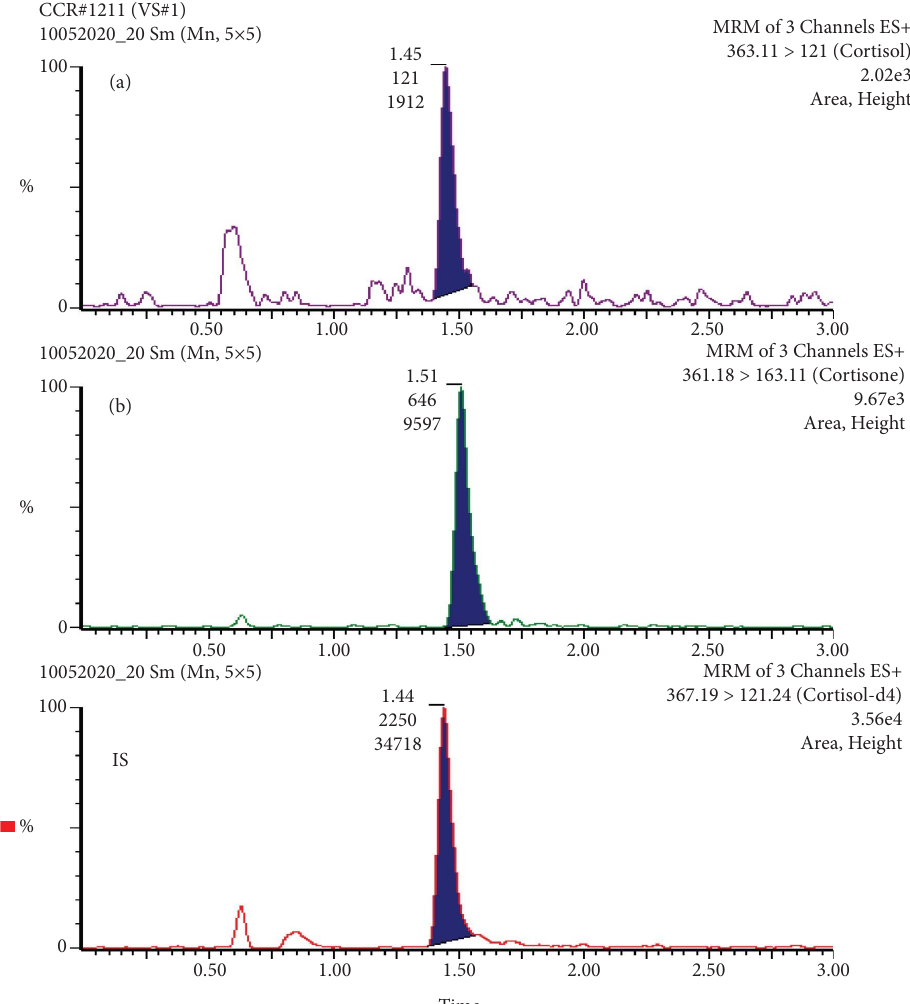
Figure 2: Multiple-reaction monitoring chromatogram of a sweat sample taken from a healthy volunteer spiked with IS (2.0ng). Te measured levels of (A) cortisol (1.8ng/mL) and (B) cortisone (13.7 ng/mL).